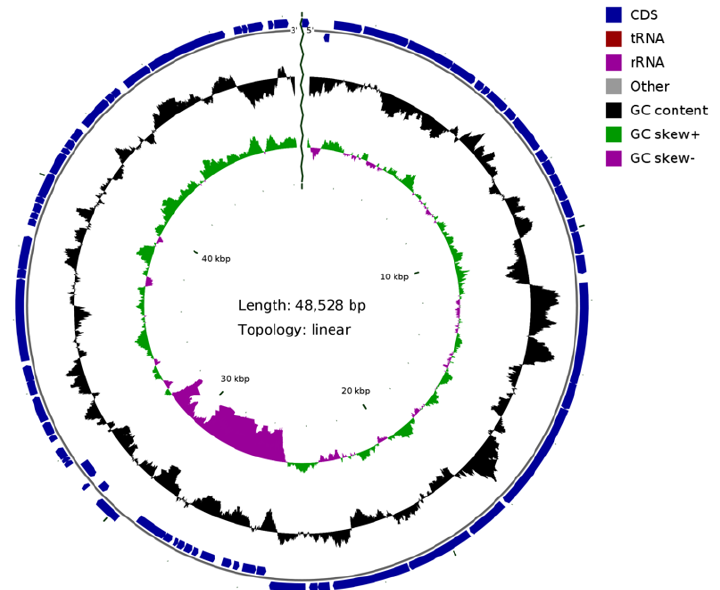
Figure 5. Schematic representation of the phage BG3P genome. Circles display (from the outside): (1) orfs transcribed in the clockwise or the counterclockwise direction. (2) G + C % content. (3) GC skew (G − C/G + C, in a 1-kb window and 0.1-kb incremental shift).